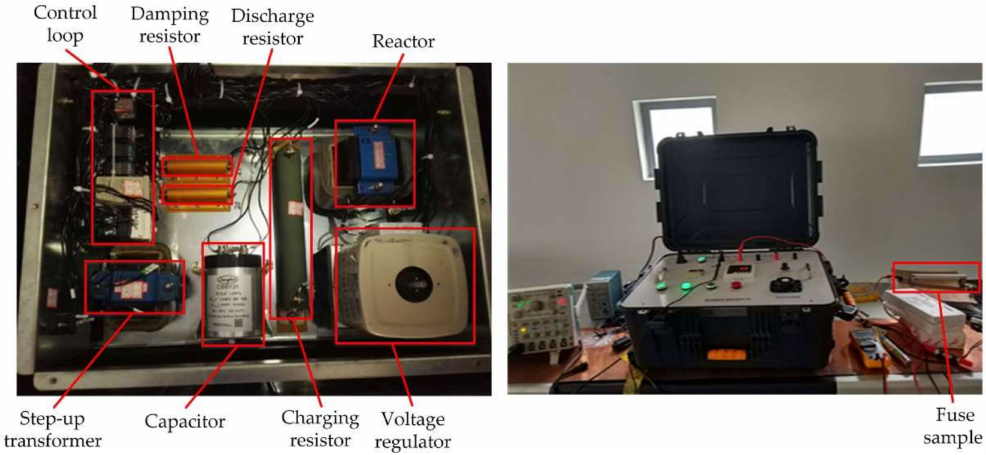
Figure 7. The picture of the test